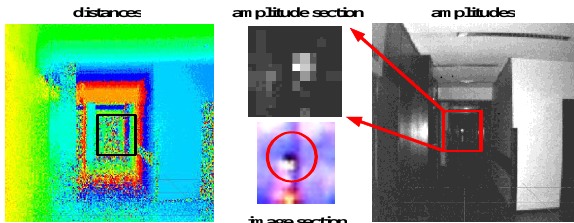
Figure 4 Recording of a room linked to a prism reflector (section; distance ca. 63 m)